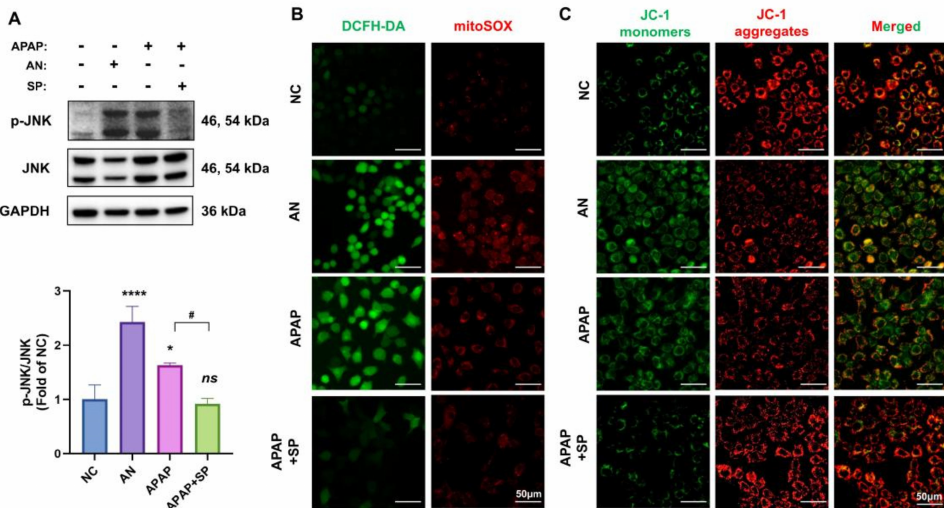
Figure 5. Inhibition of JNK activation alleviates APAP-induced mitochondrial dysfunction in AML12 cells. ( A ) Western blot analysis of p-JNK and JNK levels in AML12 cells treated with anisomycin, APAP, and SP600125 for 24 h. ( B ) The cells were stained by DCFH-DA and MitoSOX to visualize intracellular ROS. ( C ) The representative fluorescent microscopic analysis of ∆Ψ m by JC-1 staining of each group. Data are presented as the mean ± SD; n = 3; * p < 0.05, **** p < 0.0001 and ns: no significance vs. NC group; # p < 0.05 vs. APAP group. AN: anisomycin; SP: SP600125.